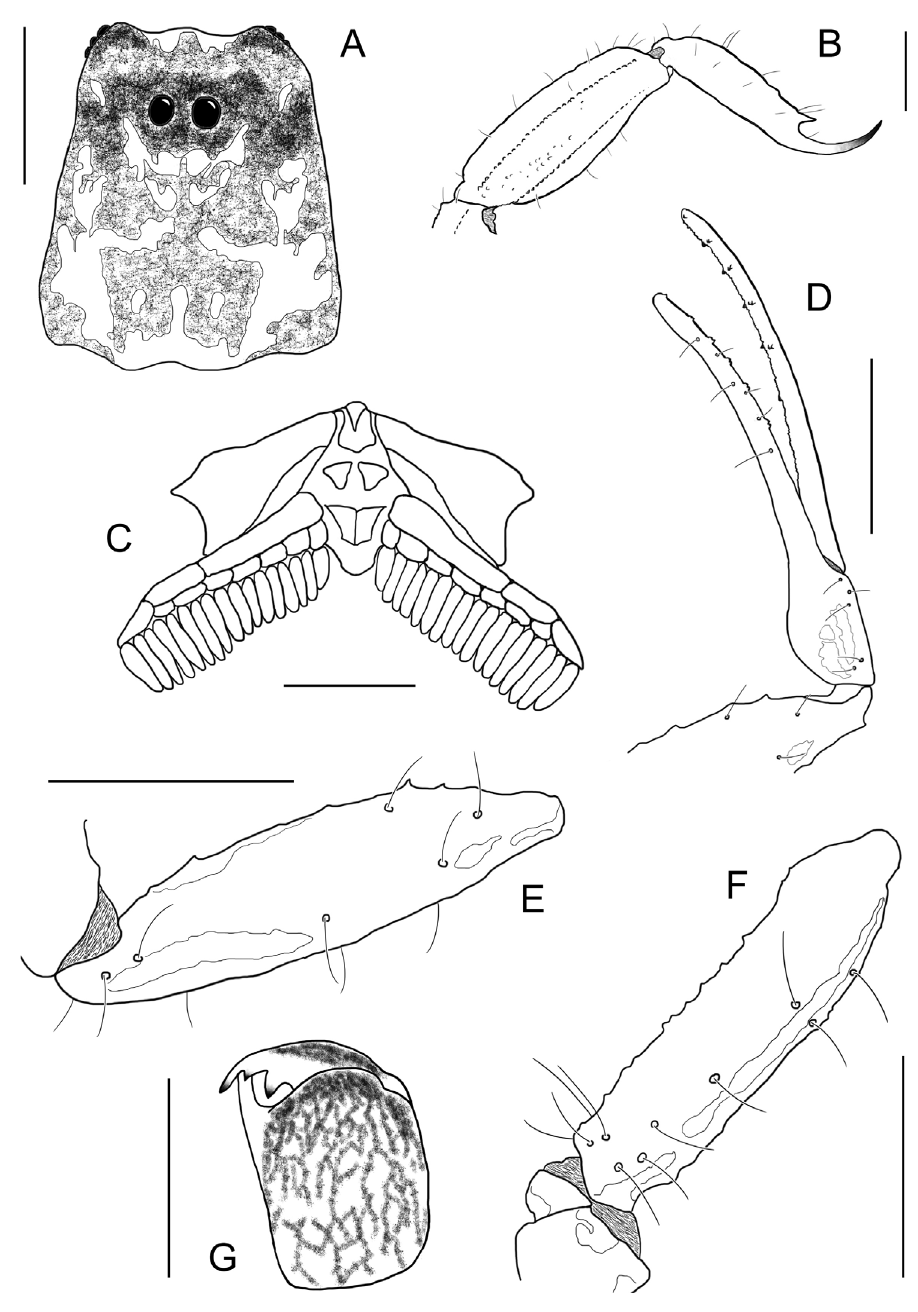
Figure 5. Ananteris kalina sp. n. male holotype. A Carapace B Metasomal segment V and telson, lateral aspect C Sternum, genital operculum, and pectines D Chela, dorso-external aspect E Patella, dorsal aspect F Femur, dorsal aspect G Chelicera. Scale bars: 1 mm except chelicera ( G ) 0.5